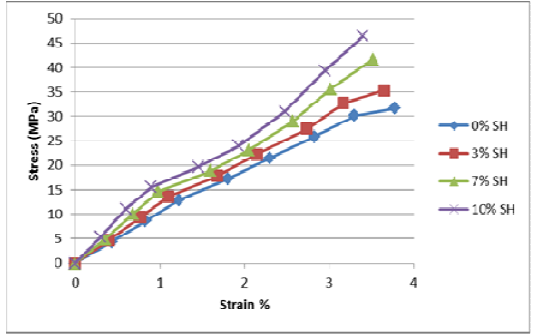
Fig. 7. Stress-Strain curves of different weight fraction of sunflower husk.